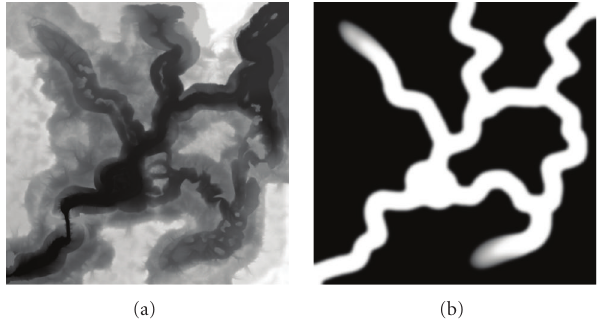
Figure 2: Inputs to the terrain-generation algorithm (a) height map (b) control